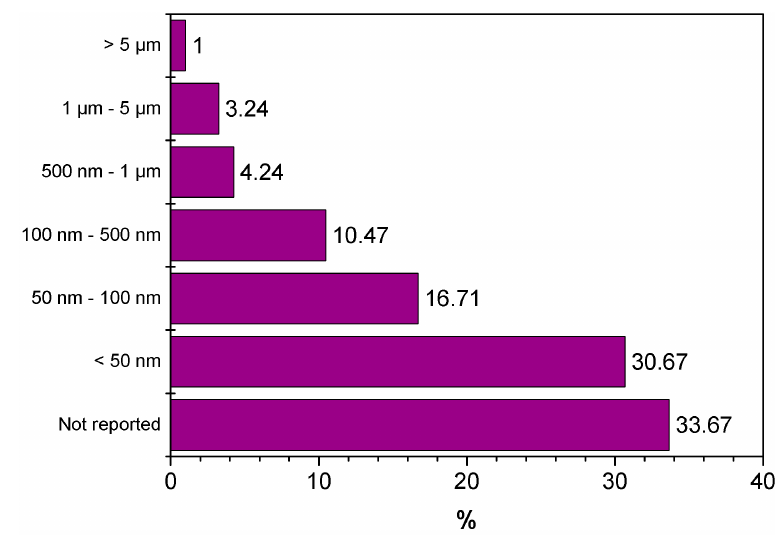
Figure 16. ZnO sizes on composites.